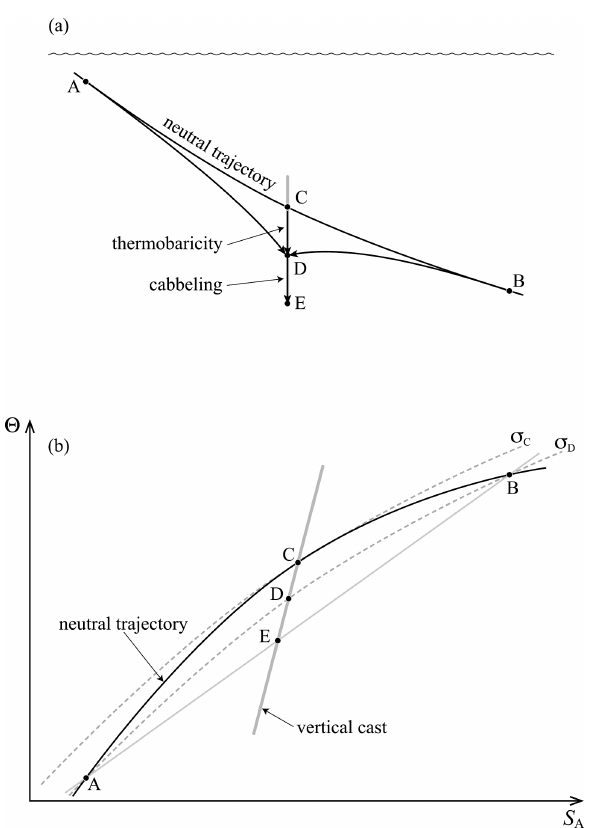
Figure 1. Sketch illustrating the two dianeutral advection processes, thermobaricity and cabbeling. Panels ( a ) and ( b ) show a neutral trajectory and a vertical cast in physical space and in S A − Θ space, respectively. The Absolute Salinity and Conservative Temperature of the ocean’s environment at the locations A–E in panel ( a ), are depicted in panel ( b ). When parcels A and B mix with one another (in the appropriate mass ratio) they produce water parcel E. This mixing between parcels A and B occurs at the pressure of point D, but the mixing occurs between parcels A and B and not with the ocean properties at this location. The potential density surface of parcel D with respect to the pressure at point D, is shown.